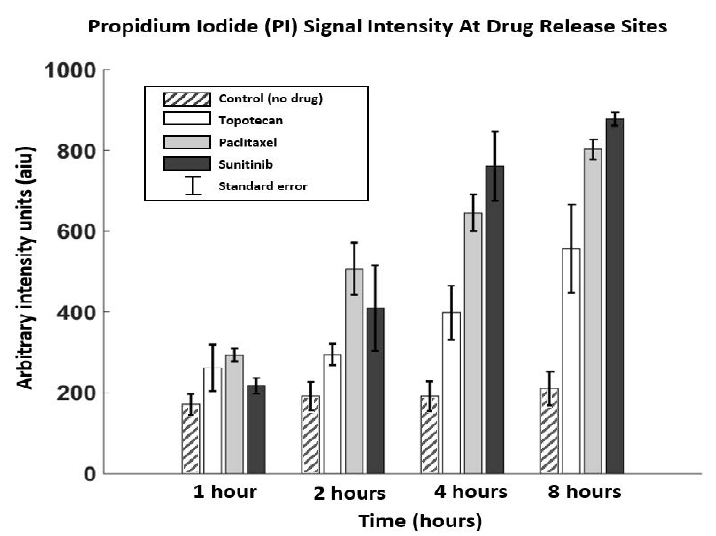
Figure 5. Mean and standard error (SEM) signal intensities obtained at each time point for each drug and control. All three drug sites had significantly higher PI signal compared to the Control site, indicating drug response ( p < 0.001). Both Sunitinib and Paclitaxel had higher signal at 8 h compared to Topotecan [p(sun vs. top) = 0.003; p(pac vs. top) = 0.01], which suggests higher therapeutic response at the delivered drug concentrations.